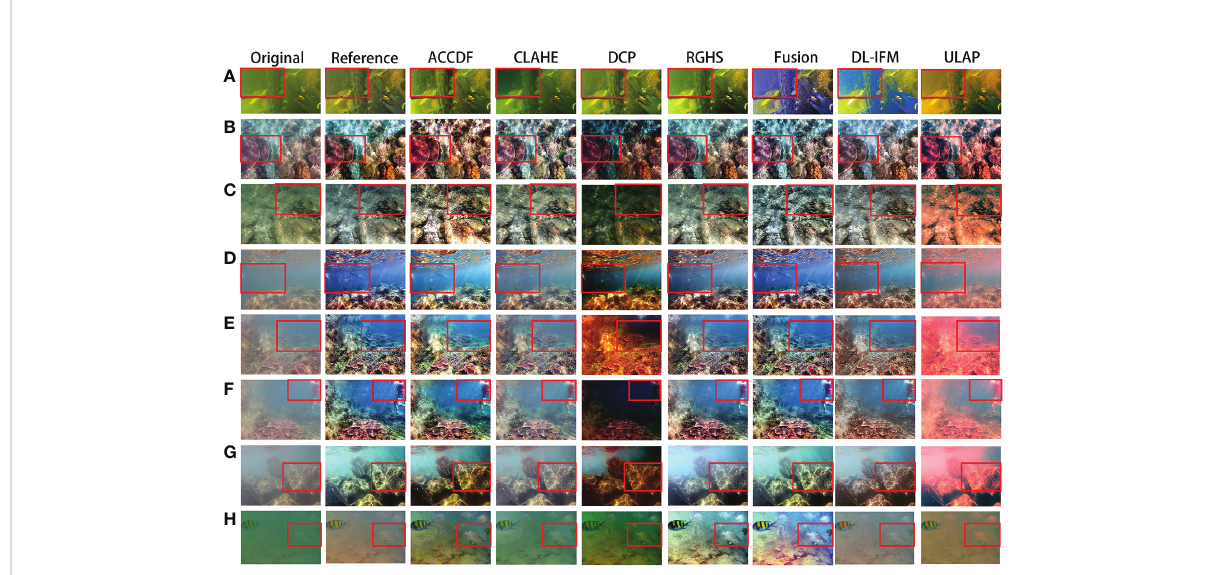
FIGURE 7 Experimental results of the comparison of the Raws dataset. Image (A – G) are eight images selected from the Raws dataset. From left to right are the original image, the ground truth image and the image processed by ACCDF, CLAHE, DCP, RGHS, FUSION, DL-IFM and ULAP methods. And the red box indicates the advantages of ACCDF over other